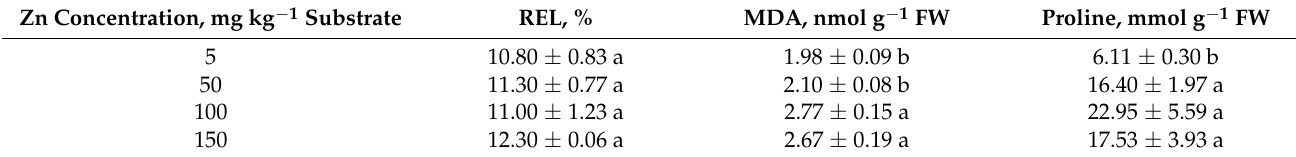
Table 5. Effect of Zn excess REL, MDA, and proline content in S. alba